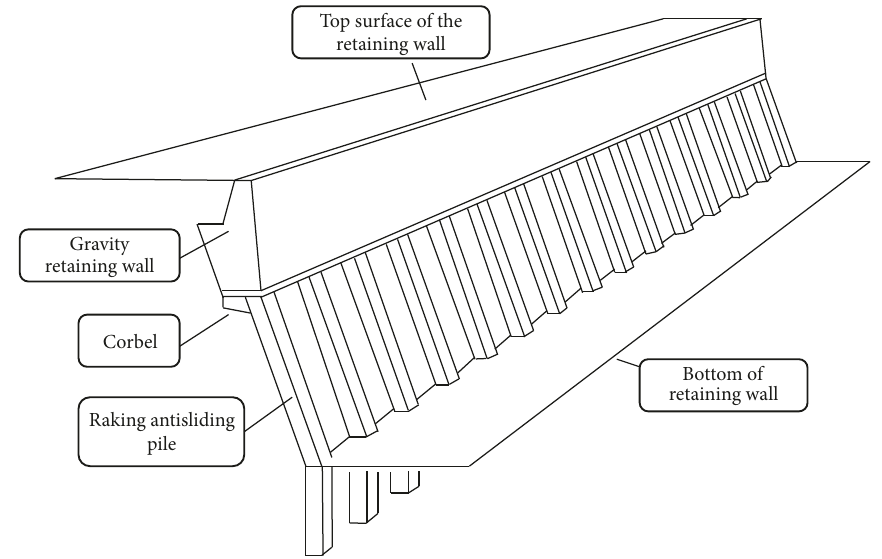
Figure 1: The overall schematic of the self-balancing retaining wall.